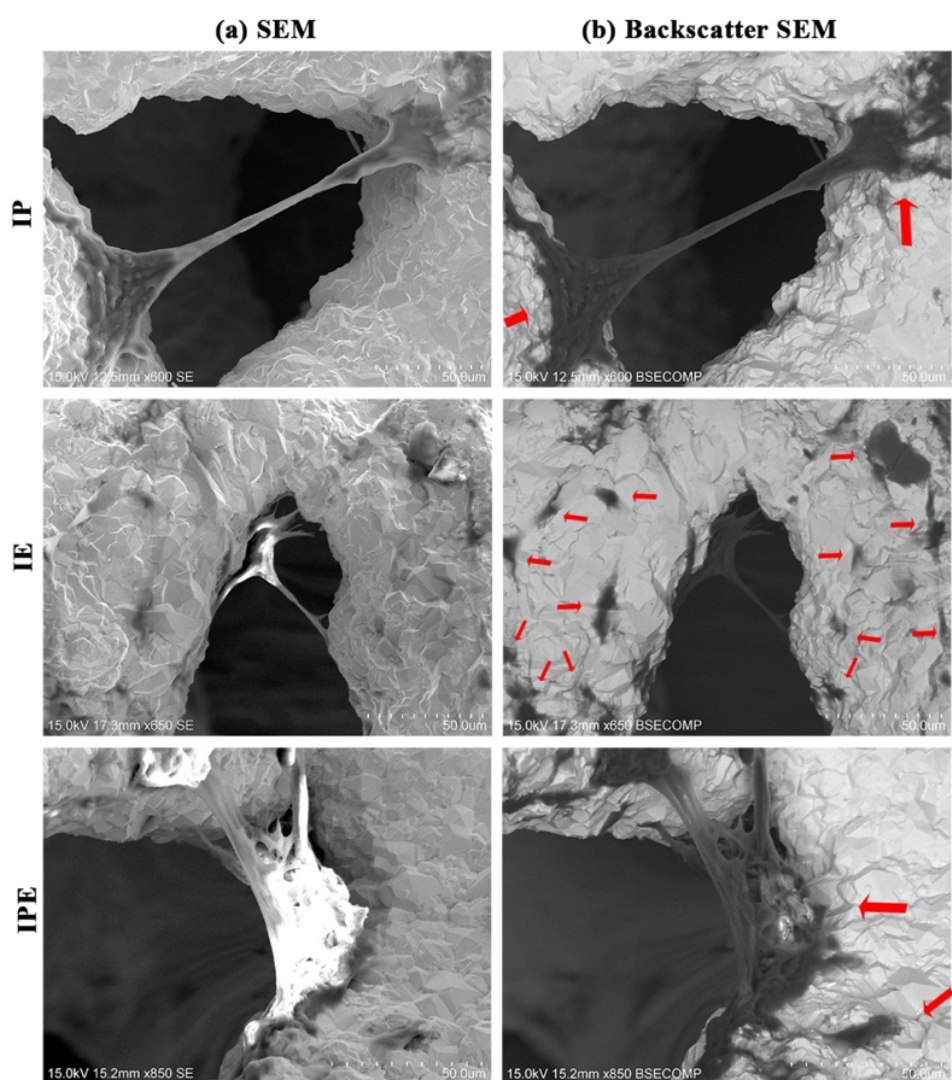
Figure 5. Cell adhesion and cell penetration ( a ) Cell adhesion in Cell-Discs with different IP, IE, and IPE groups under SEM ( b ) Cell penetration (Black spots marked by red arrows) in Cell-Discs with different IP, IE, and IPE groups under backscatter SEM.